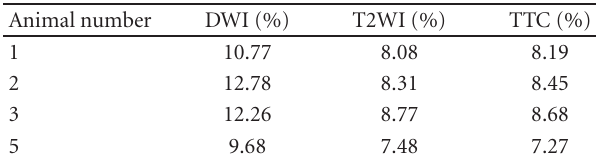
Table 1: LVP on DWI at 0 hour, T2WI at 48 hours after reperfusion and